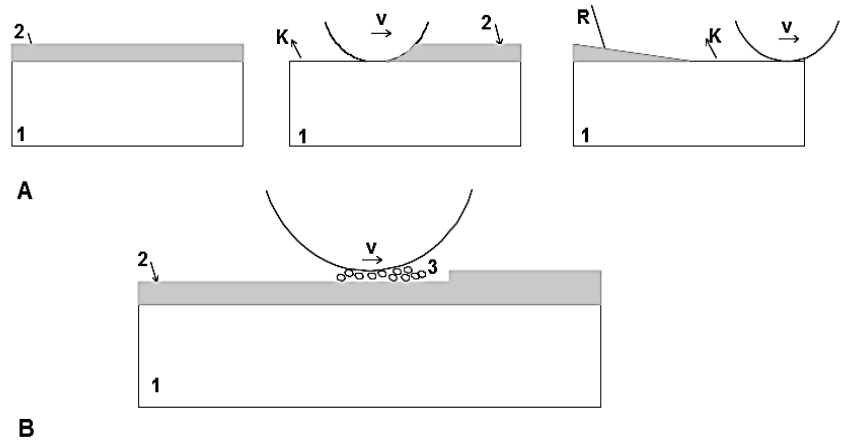
Figure 2. Diagram of the tribocorrosive wear mechanism: ( A )—intensification of the corrosion process due to friction, ( B )—intensification of the wear process due to the action of oxide layer particles; designations: 1—base material, 2—oxide layer, 3—crushed particles of the oxide layer, R—repassivation, K—corrosion, v—sliding velocity.